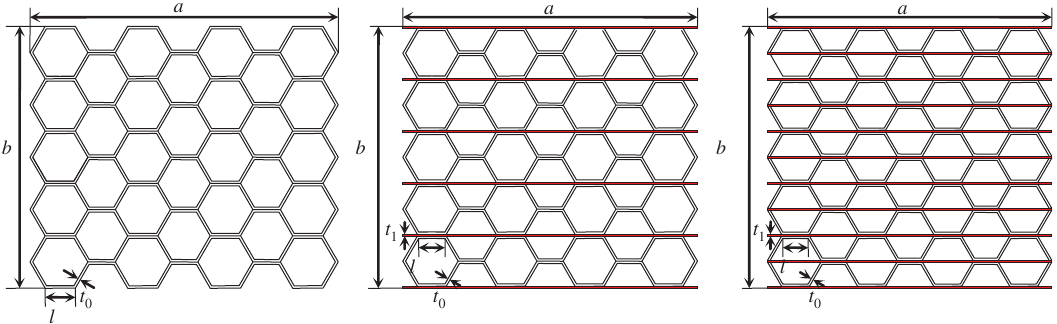
Figure 2: Geometric configuration of honeycomb.